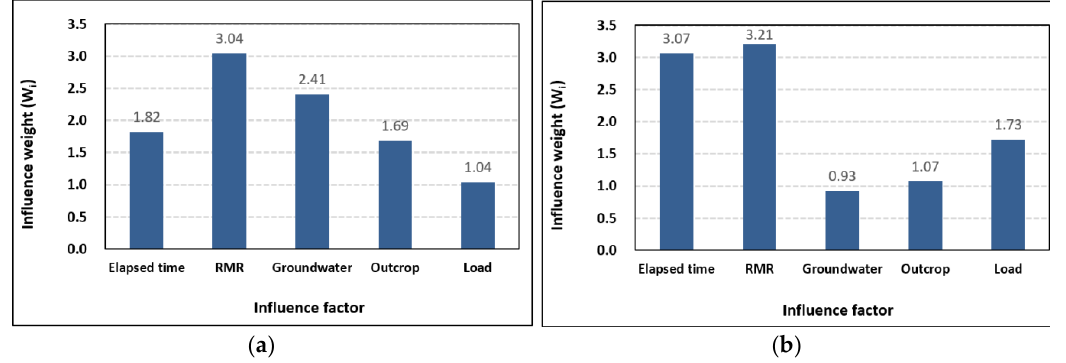
Figure 14. Influence weights for ( a ) coal mines and ( b ) other types of mines.